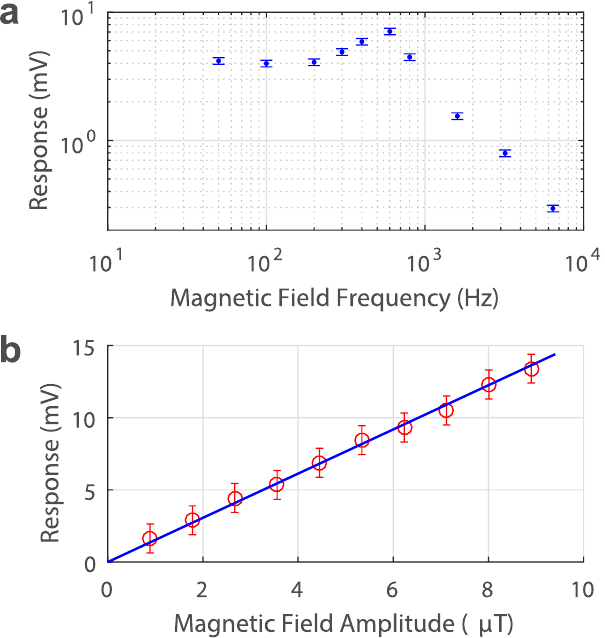
Figure 3. Frequency and amplitude response. ( a ) Frequency response and ( b ) amplitude response of the microcavity magnetometer.